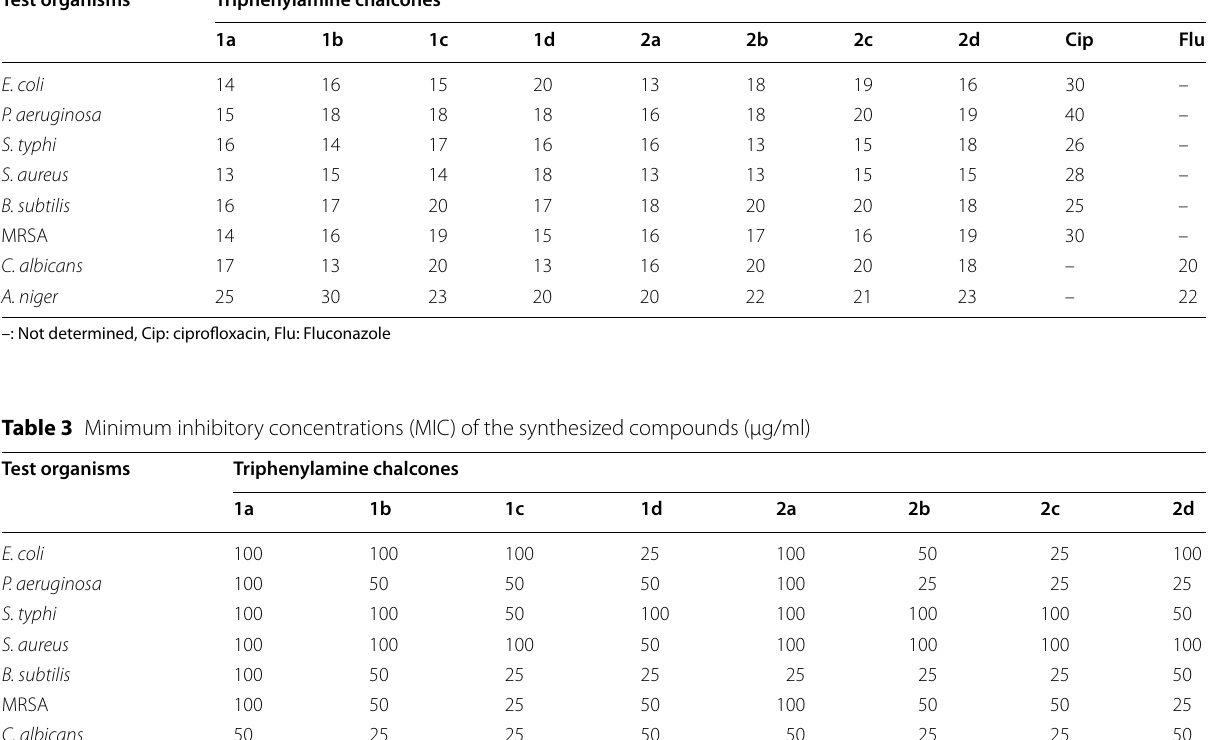
M.F: molecular formula, M.W: molecular weight, M.P: melting point, R f : retention factor Table 2 Zone of inhibition (mm) Test organisms